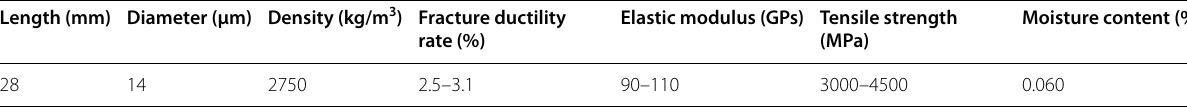
Table 2 Physical and mechanical properties of basalt